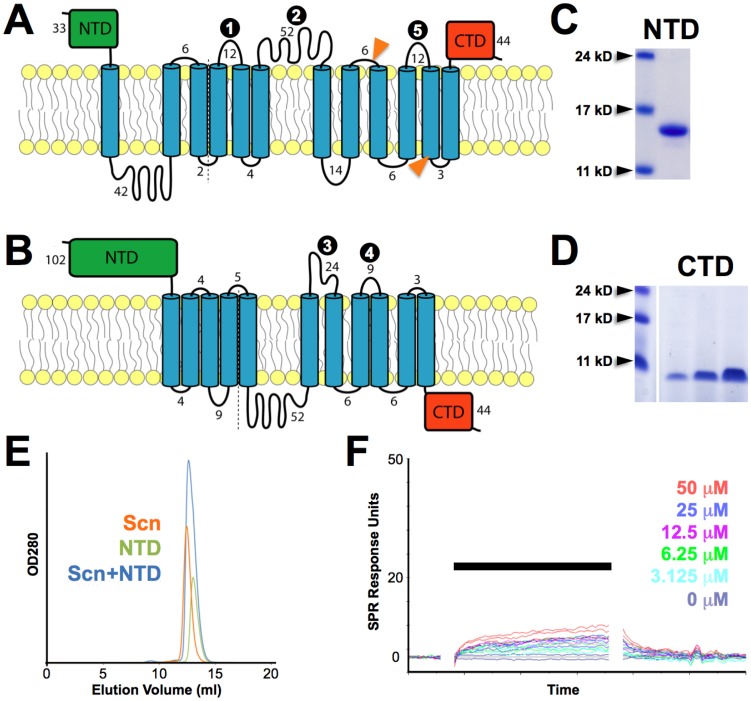
BOCT N-and C-terminal domains do not bind Scn.Predicted BOCT membrane topologies are shown, either as determined in [15] (A) or calculated here (B), with transmembrane-spanning helices shown as blue cylinders. The sequence lengths of the NTD (green), CTD (red) and connecting loops are indicated; loops synthesized as peptides for binding analyses are indicated with numbered black circles, corresponding to the numbering in the Materials & Methods section. The amino termini of fragments used to originally identify BOCT as a Scn receptor [15] are indicated with orange arrows in (A). PAGE analyses of bacterially-expressed soluble, purified NTD (C) and CTD (D) are shown. SEC analysis of NTD/Scn is shown in (E). Complex formation would have been indicated by a shift in the Scn+NTD peak to lower elution volumes; in this case, the Scn/NTD mixture runs as the simple summation of the Scn and NTD alone peaks, indicating no binding under these conditions. (F) SPR analysis of Scn/CTD binding, with Scn analyte concentrations indicated. The bar indicates the sample injection period (association phase); gaps in the sensorgrams cover transients associated with injections.